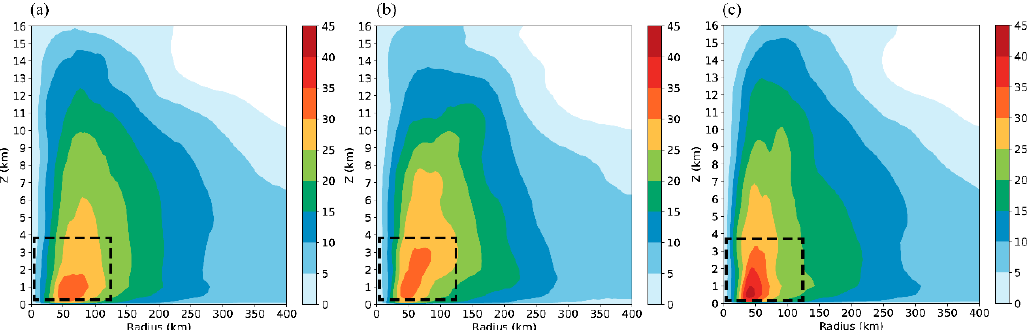
Figure 10. Azimuthally averaged tangential wind speed (unit: m s − 1 ) of the ( a ) CTRL, ( b ) DA_len1.0 and ( c ) DA_len0.25 experiments at 0000 UTC on 9 July 2015.